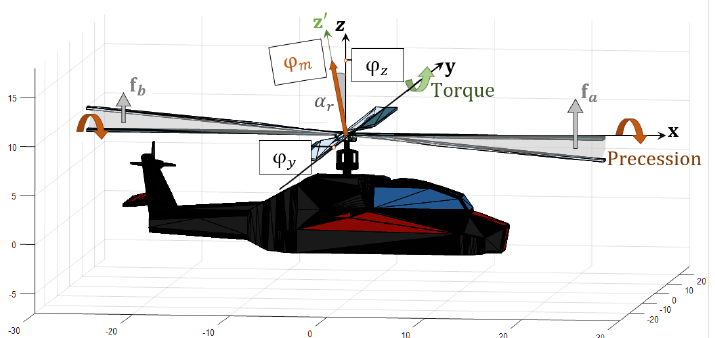
Figure 6. Illustration of a positive variation of the angle of attack along the x -axis, where ϕ y = − 1 u m sin α r and ϕ z = 1 u m cos α r are the projections of the thrust vector ϕ m along the y - and z -axis, 2 2 respectively. The maneuver to control rolling assigns to the blades an angle such that a greater amount of force is produced in the positive x -axis, namely f a , with respect to the force in the negative x -axis, namely f b . Those two vector forces produce a torque and a precession rotation due to the gyroscopic effect.